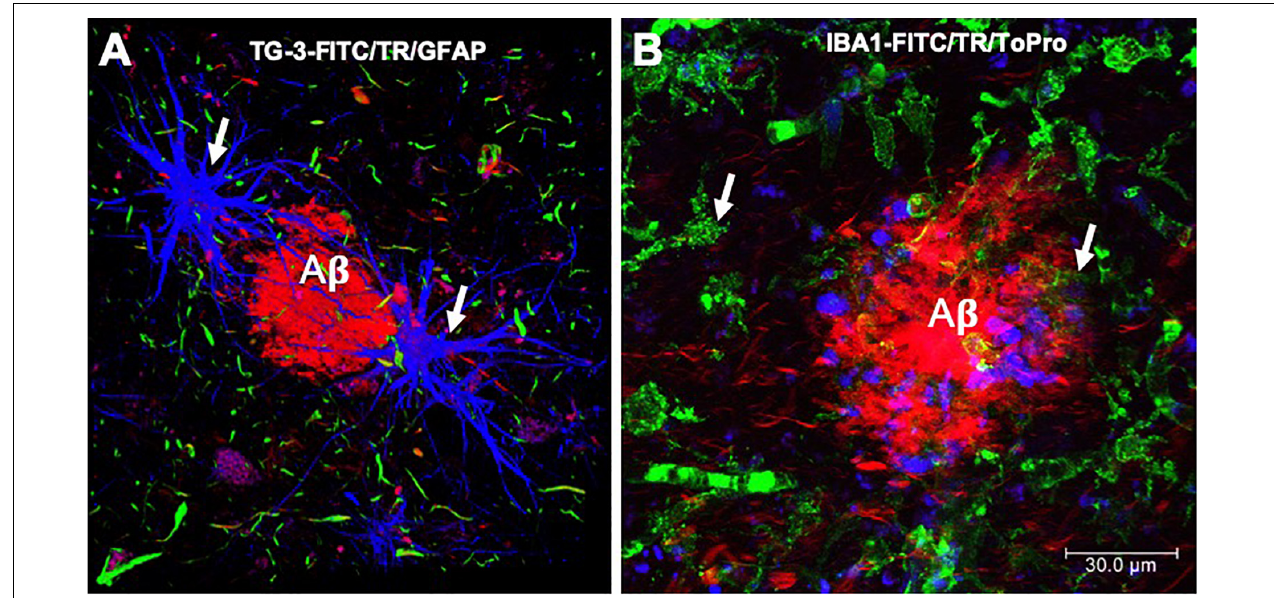
FIGURE 4 | Immunofluorescence of amyloid plaques. (A) Amyloid β -peptide (A β ) deposit recognized by thiazine red (TR, red color ), which is bordered by glial cells (GFAP, blue color ) and by dystrophic neurites, recognized by the antibody that reacts with phosphorylated tau protein (TG-3, green color ). (B) Amyloid plaque is recognized by the TR dye ( red color ). At the periphery, microglial cells are recognized by the Iba-1 antibody ( green color ) and the cell nuclei with To-Pro ( blue color ). Images obtained with a Leica SP8 confocal microscope.